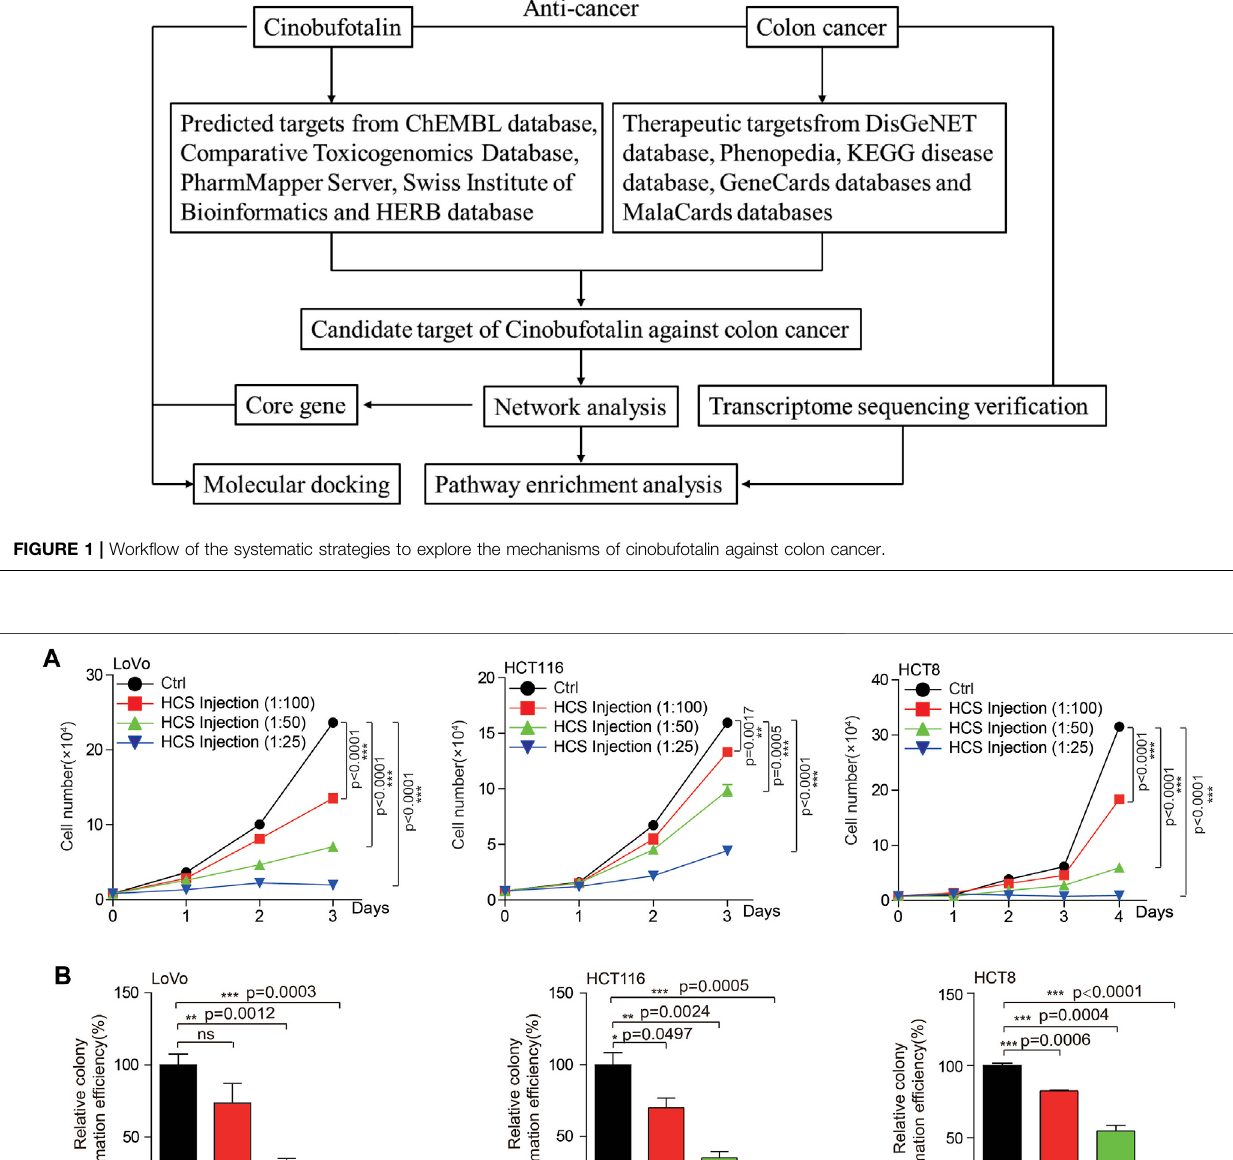
Frontiers in Pharmacology |